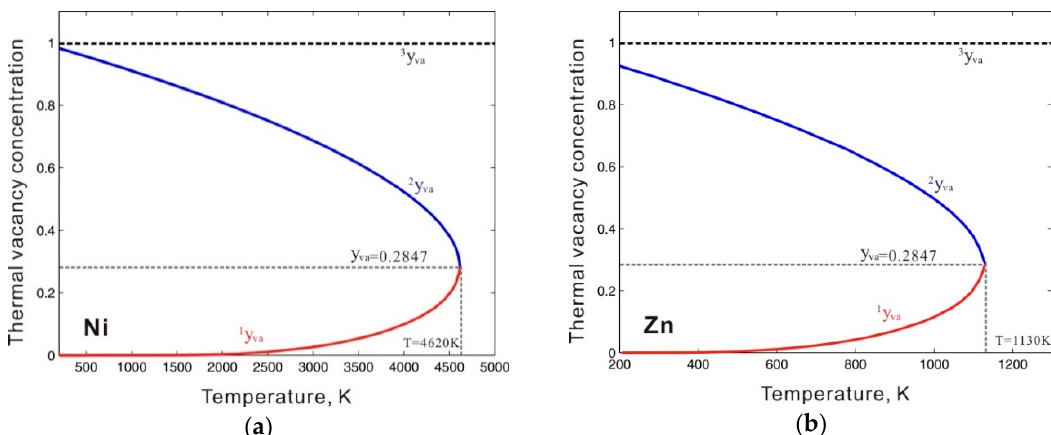
Figure 1. Thermal vacancy concentrations of ( a ) bcc Ni and ( b ) bcc Zn evaluated according to the thermodynamic descriptions by Xiong et al. [11]. 1 y va , 2 y va , and 3 y va are the three analytical solutions for the thermal vacancy concentrations in bcc_A2 Ni or Zn.